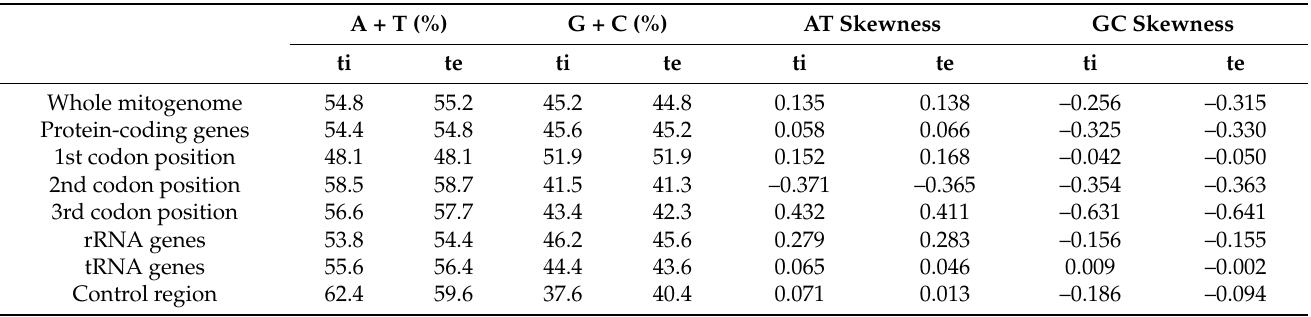
ti represents Exostoma tibetanum ; te represents Exostoma tenuicaudatum